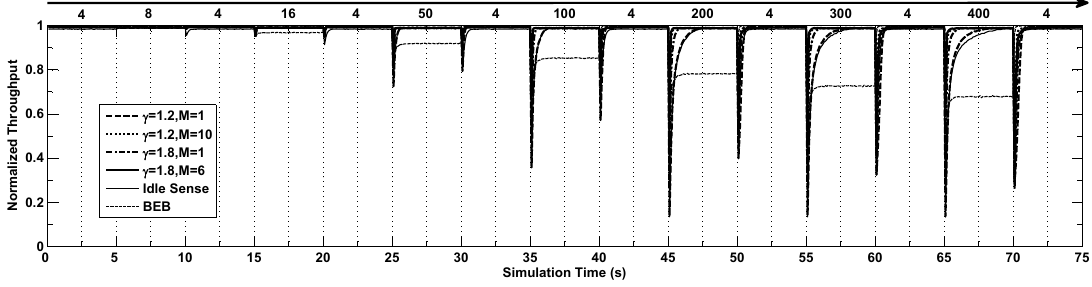
Figure 7. The normalized throughput performance of M -level contention window tuning algorithm with different M and γ , idle sense algorithm and BEB when the number of contention nodes